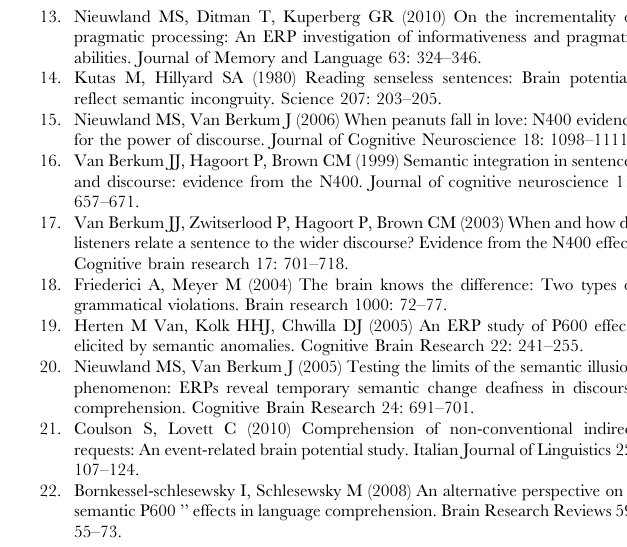
Figure S1 ERP waves for the Ironic (red line) and the Literal (blue line) conditions at Pz. Table S1 Examples of ironic and literal stories. Table S2 Examples of decoys. Table S3 Examples of positive